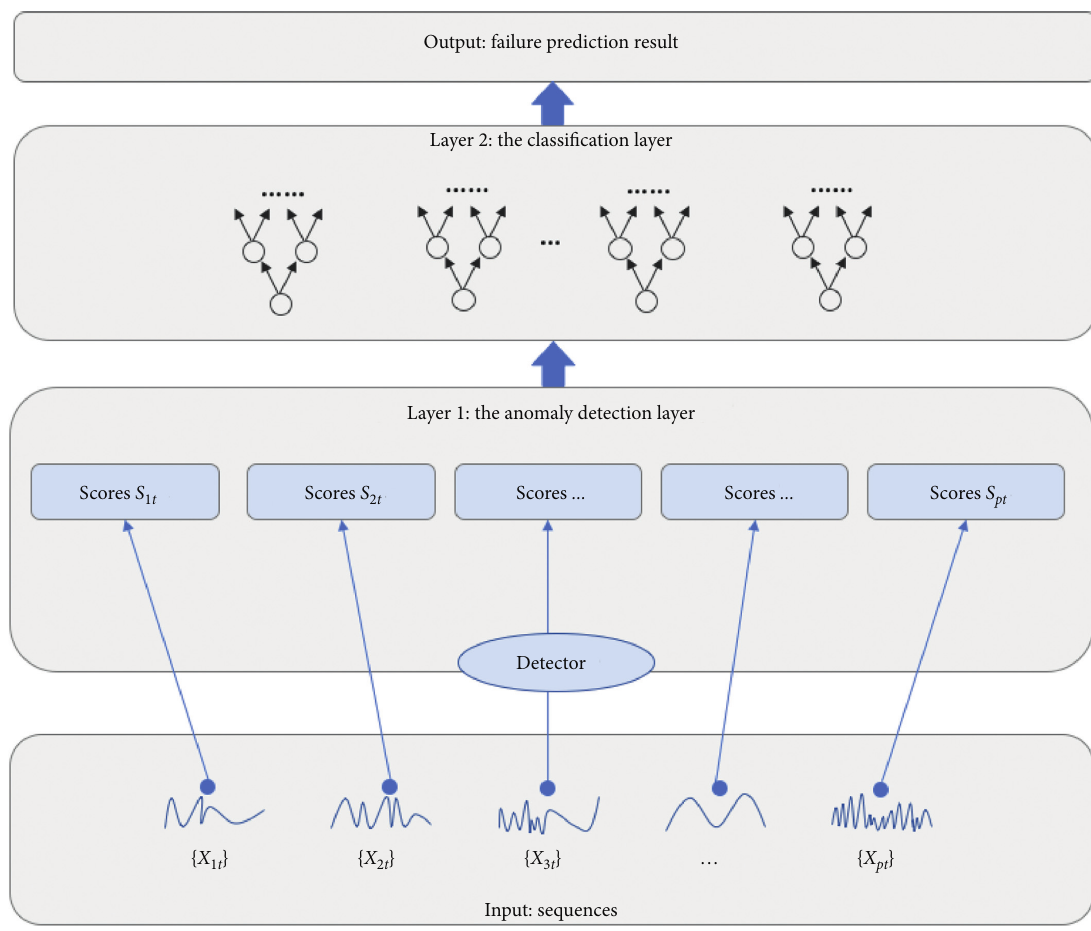
Figure 1: Two-layer prediction